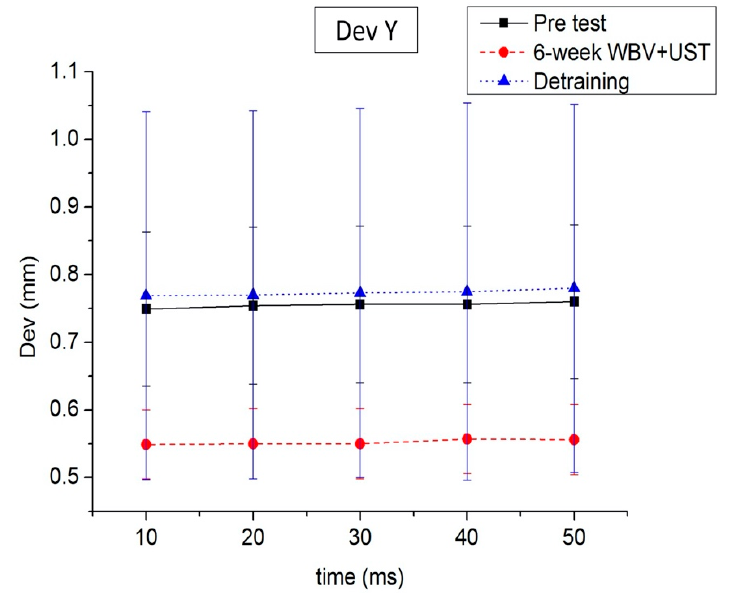
Figure 4. The difference phase during 10–50 ms-DevY of the shooting performance.